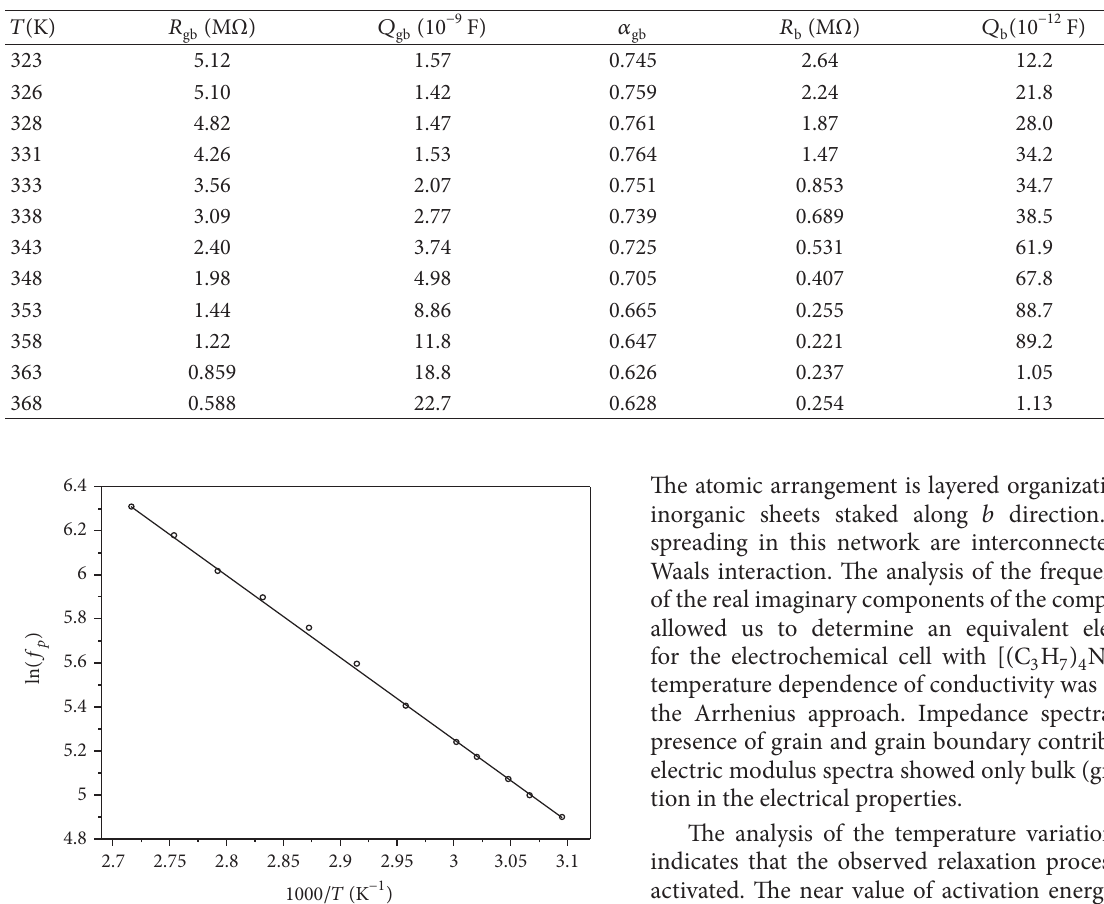
T 4: Fitting parameter obtained from impedance spectroscopy at different temperature